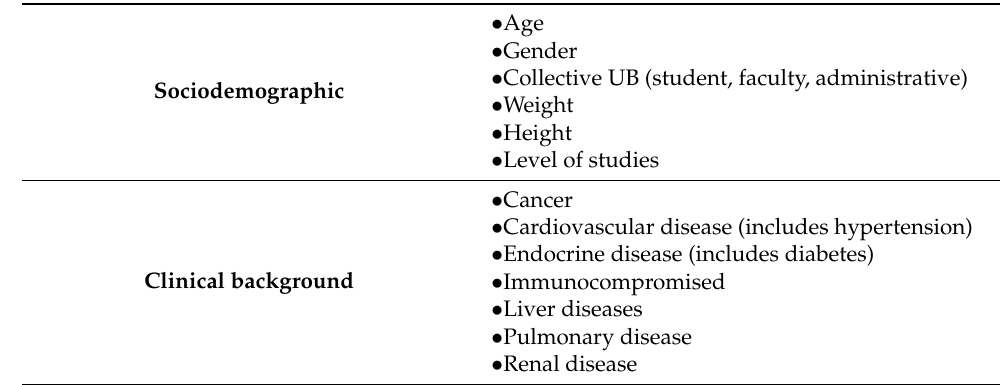
Table A1. Online epidemiological